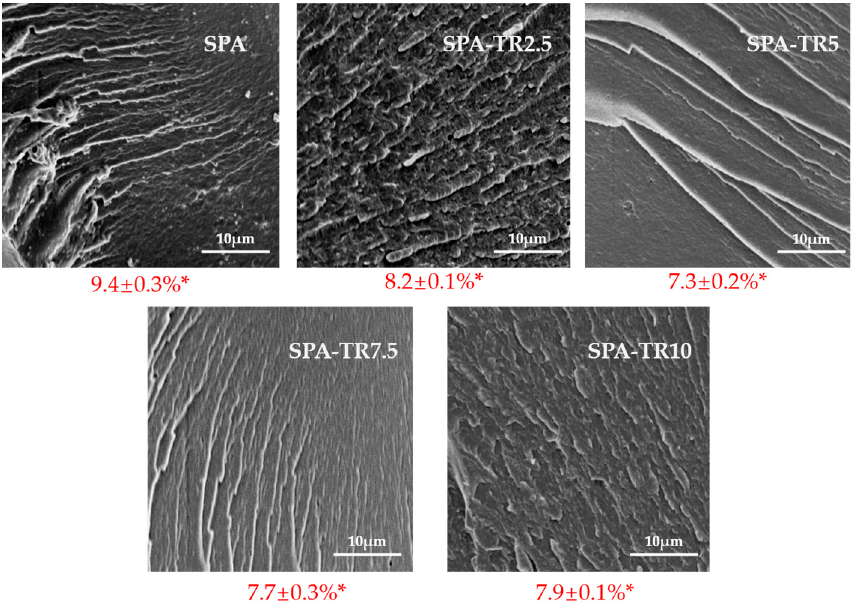
Figure 4. The fracture surface micrograph of different cured adhesives (* represents the moisture uptake of different cured adhesives). uptake of different cured